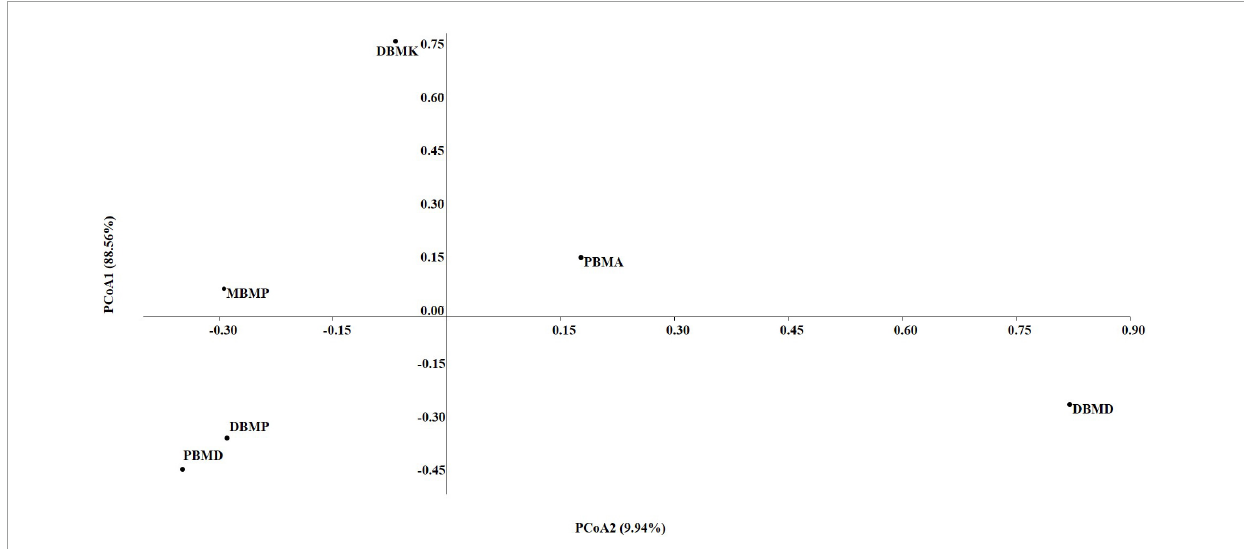
FIGURE6 PCA plot for beta diversity analysis via Jaccard at the bacterial genus level.